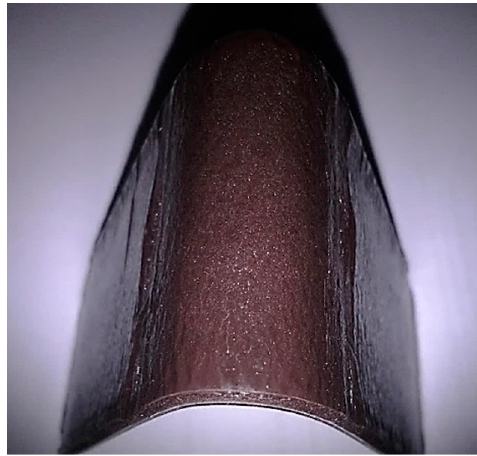
Figure 10. Validated sample for flexural test.